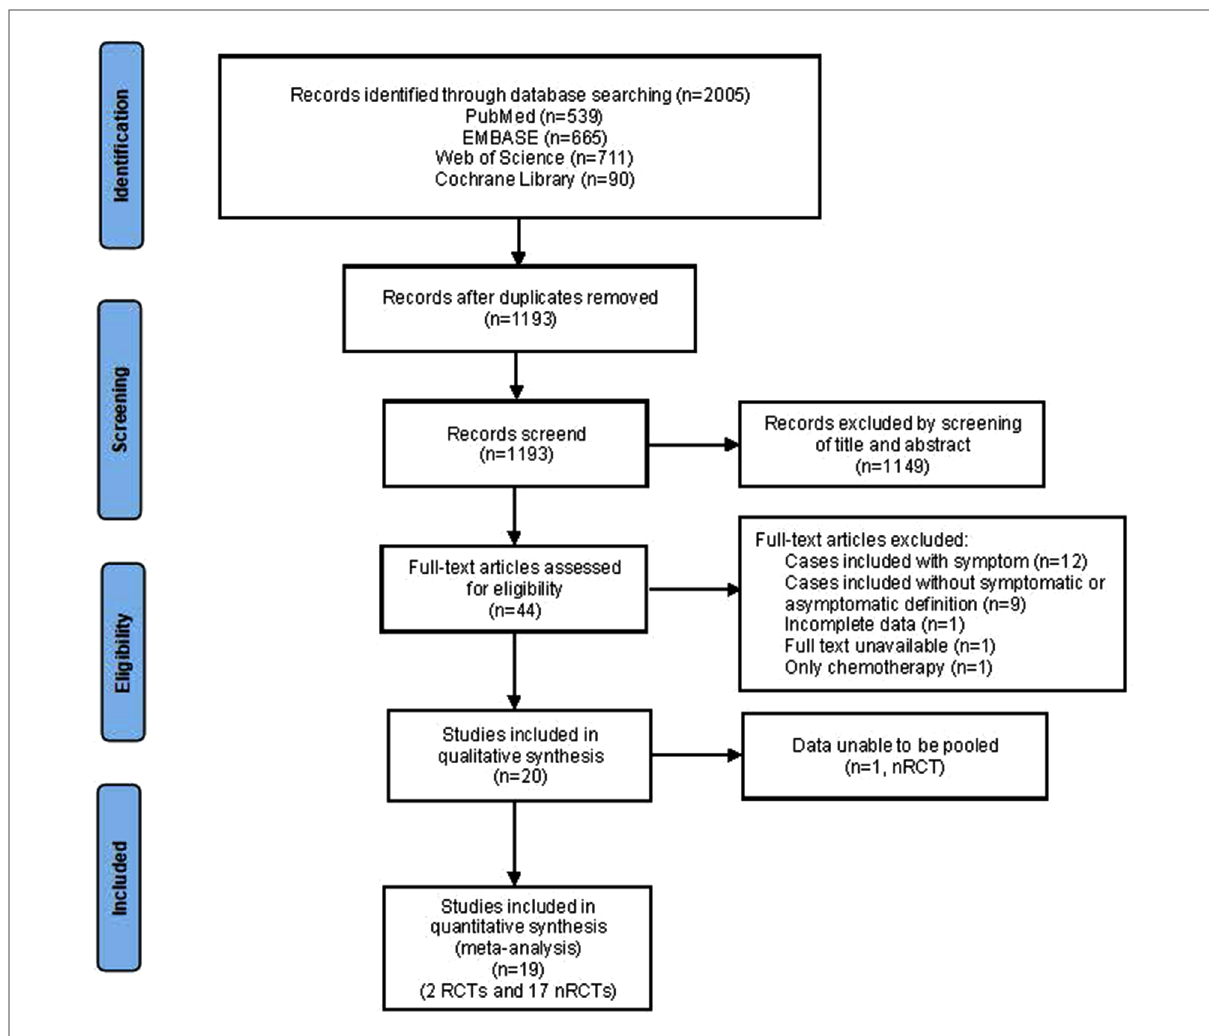
FIGURE 1 PRISMA selection fl ow